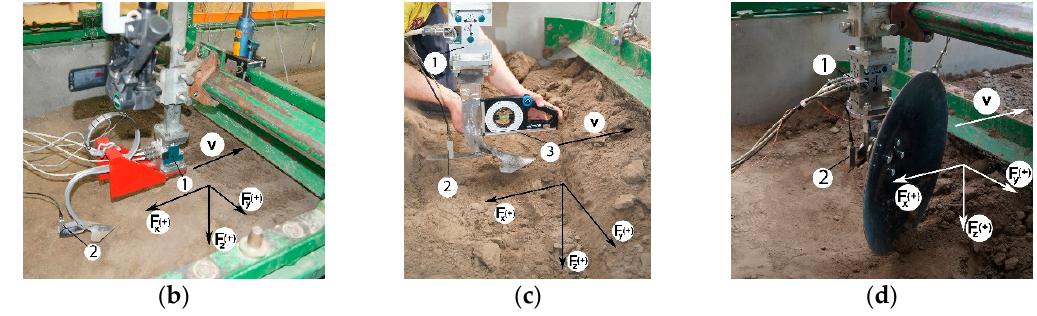
Figure 1. Tools used in the research: ( a ) duckfoot, ( b ) VCO-tine, ( c ) stiff tine, ( d ) a coulter with a smooth cutting edge; 1—strain gauge three-way force sensor CS3D, 2—three-way acceleration sensor MA 24.01 L N:628/10.3 × 160 m · s –2 , 3—inclinometer and protector SLANT AL200, F x , F y , F z —component forces: draught, lateral and vertical, respectively, N, v —working speed of tool, m · s –1 , (+)—positive